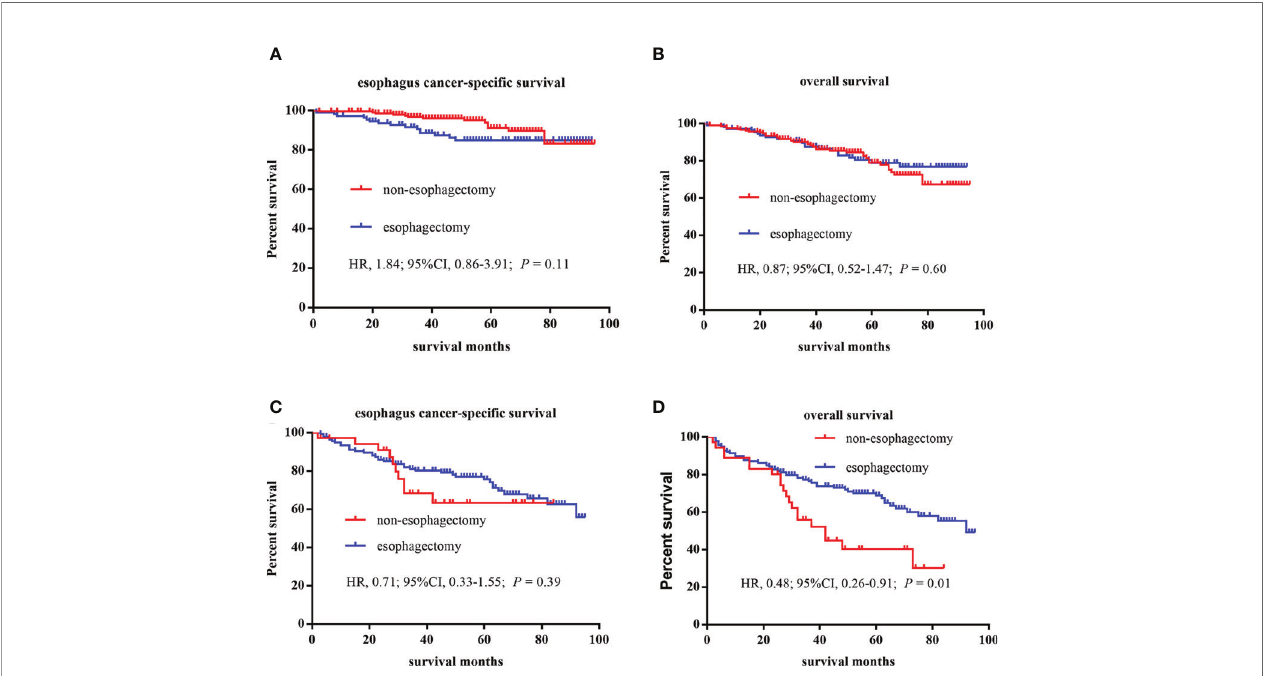
FIGURE 2 | Kaplan – Meier curves of survival estimates for T1a and T1b stage esophagus cancer patients who underwent non-esophagectomy and esophagectomy. (A) , esophagus cancer – speci fi c survival for T1a stage patients. (B) , overall survival for T1a stage patients. (C) , esophagus cancer – speci fi c survival for T1b stage patients. (D) , overall survival for T1b stage patients. HR, hazard ratio; CI, con fi dence interval.